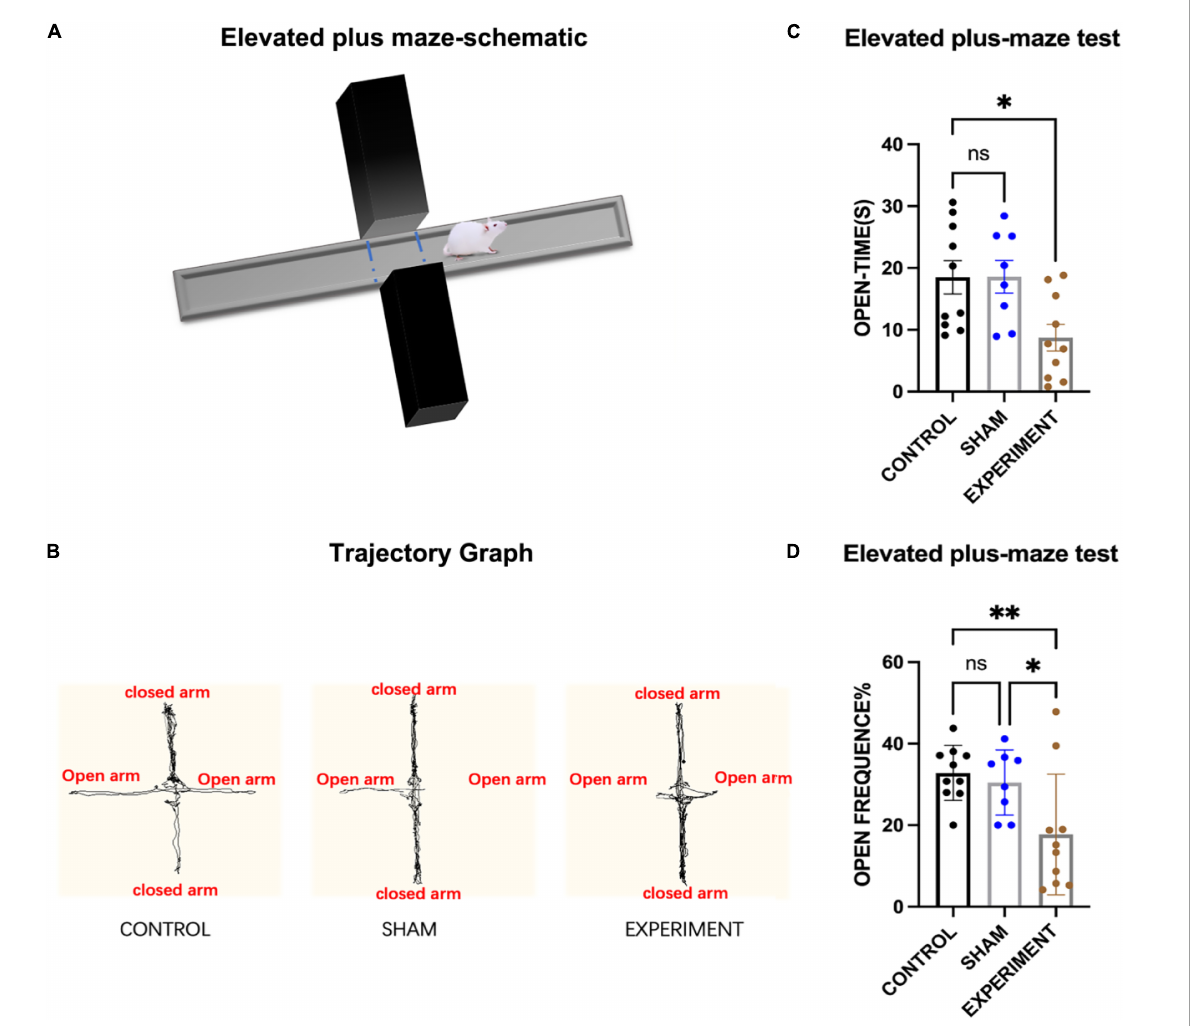
FIGURE4 Elevated plus-maze test. (A) Schematic diagram of the elevated plus-maze test. (B) Movement trajectories of the rats. (C) The times spent in the open arms (mean ± SD). (D) The frequencies entering the open arms (mean ± SD; open frequency = number of times entering open arms/total number of times entering open and closed arms). ∗ p < 0.05, ∗∗ p <